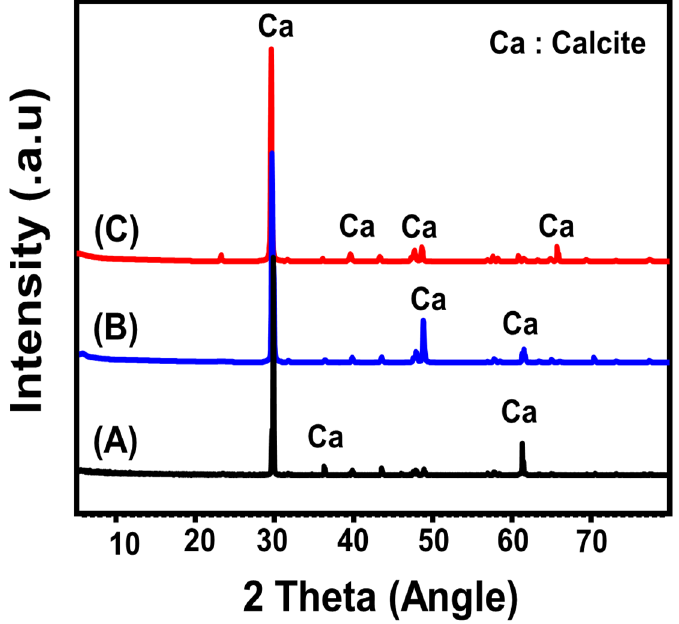
Figure 1. XRD patterns of the different evaluated calcite samples (A: CA, B: L.CA, and C: